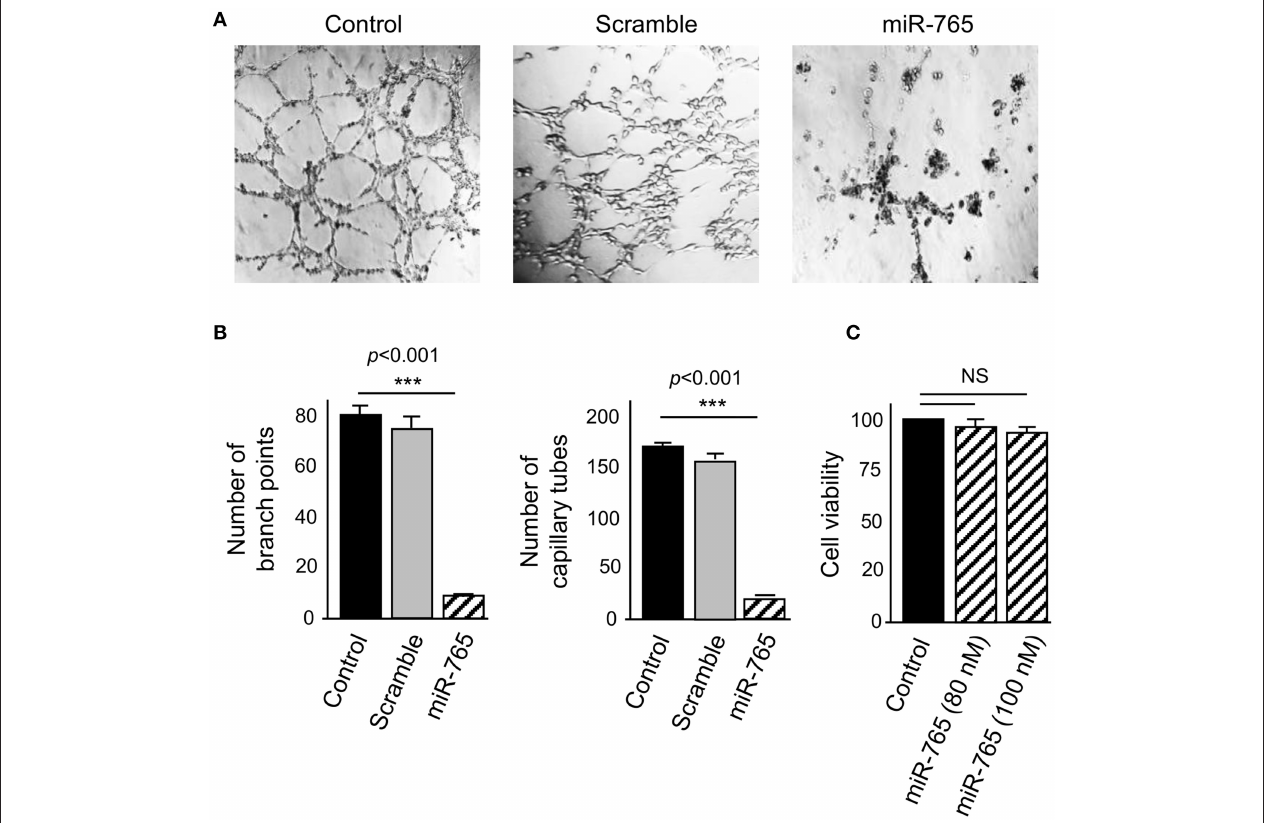
FIGURE 4 | miR-765 inhibits hypoxia-induced 3D channels-like structures. (A) 3D channels-like structures of SKOV3 cells transfected with miR-765 mimics (right panel), scramble (middle panel) and no-transfected control cells (left panel) and grown for 48h in hypoxia and then 12h in matrigel. (B) Graphical representation of the number of branch points and capillary-like channels from (A) . (C) Cell viability assays of SKOV3 cells transfected with increasing concentrations of miR-765. Experiments were performed by three times by triplicate and data were expressed as mean ± S.D. *** p < 0.001. NS,